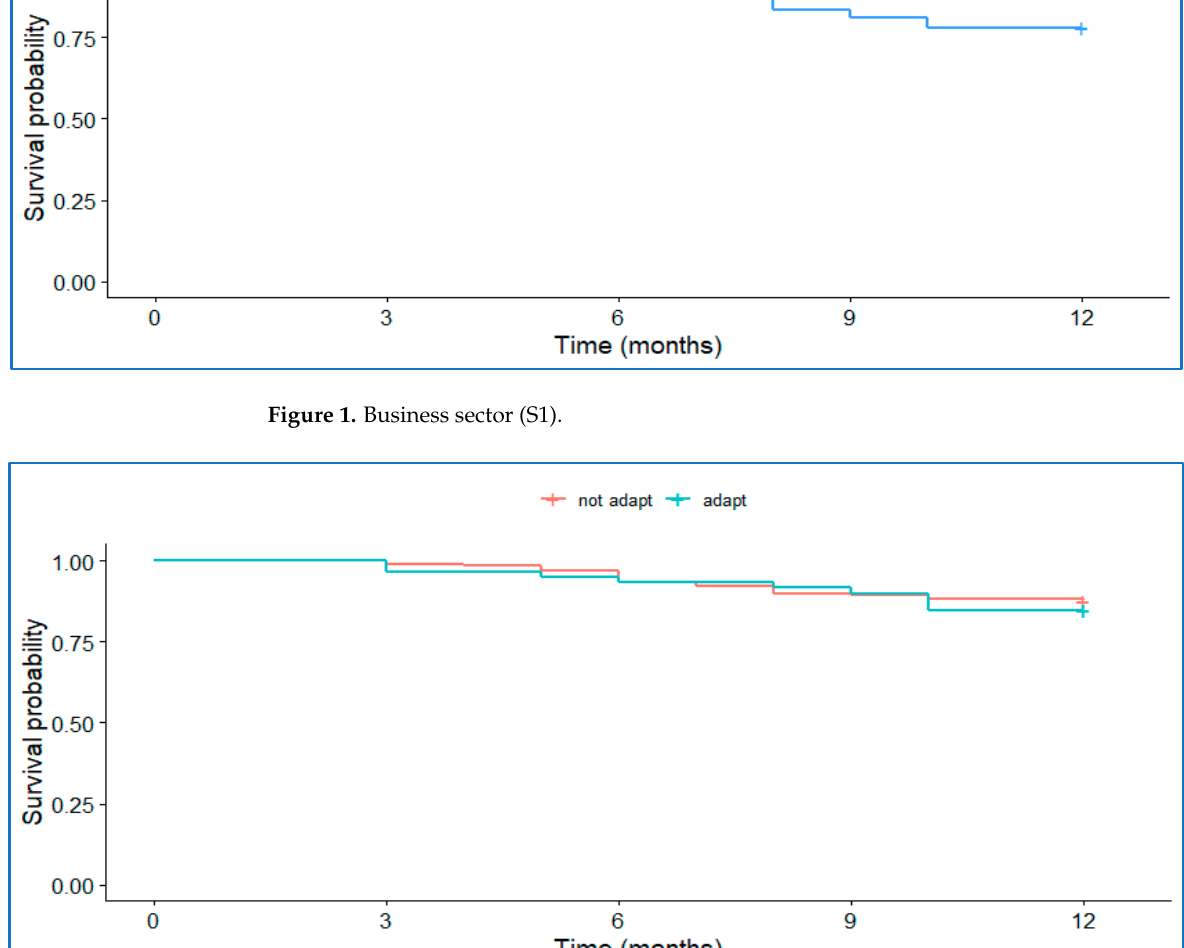
Figure 2. Adaptation by debt restructuring (Ad10).